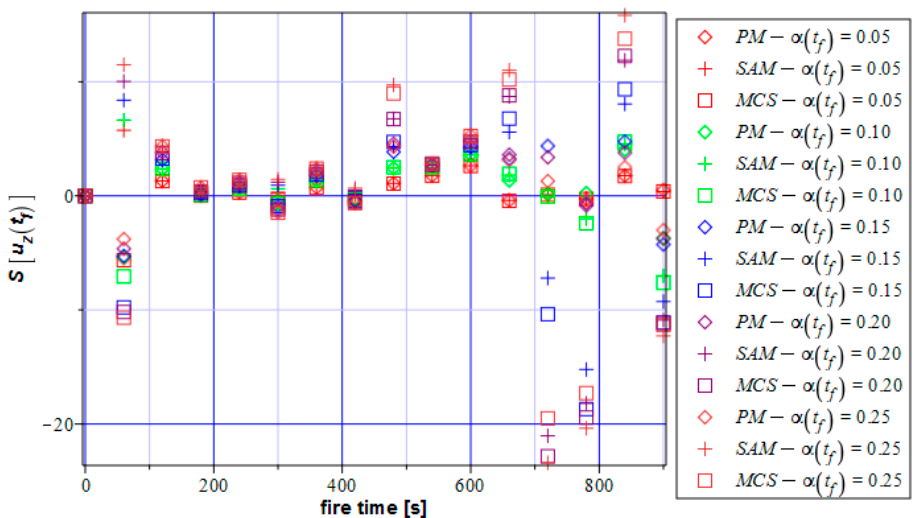
Figure 13. The skewness of the vertical deflections.